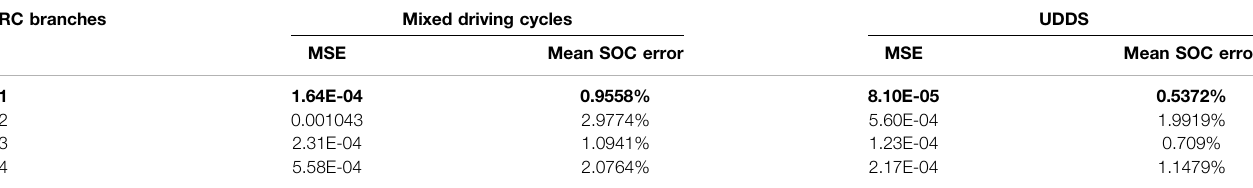
TABLE 20 | Augmented ECM-based H-in fi nity with 10% bias.